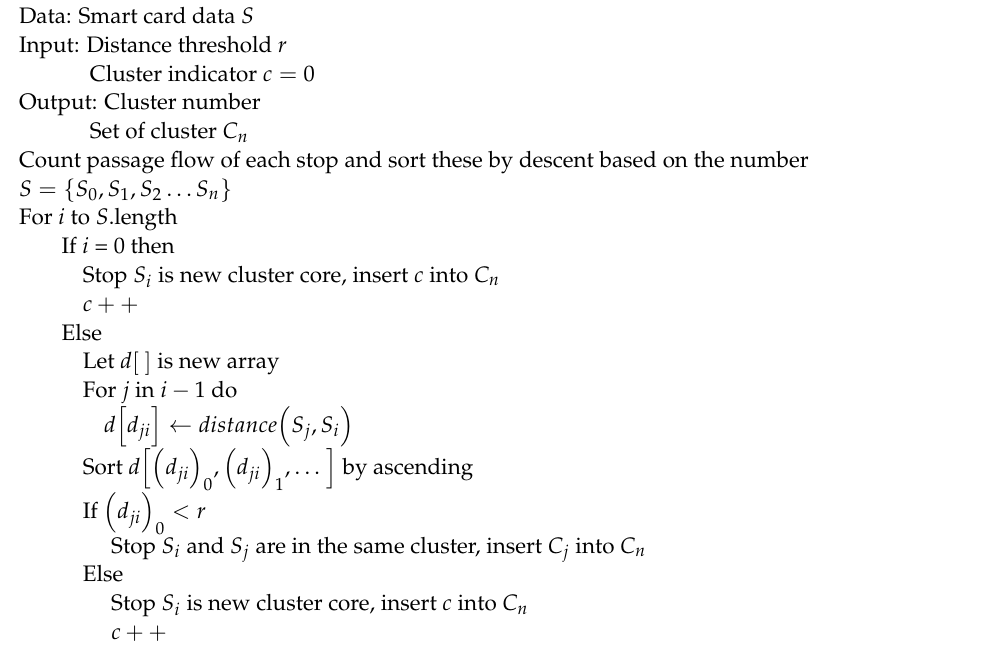
Algorithm 1. Clustering method based on high frequency and